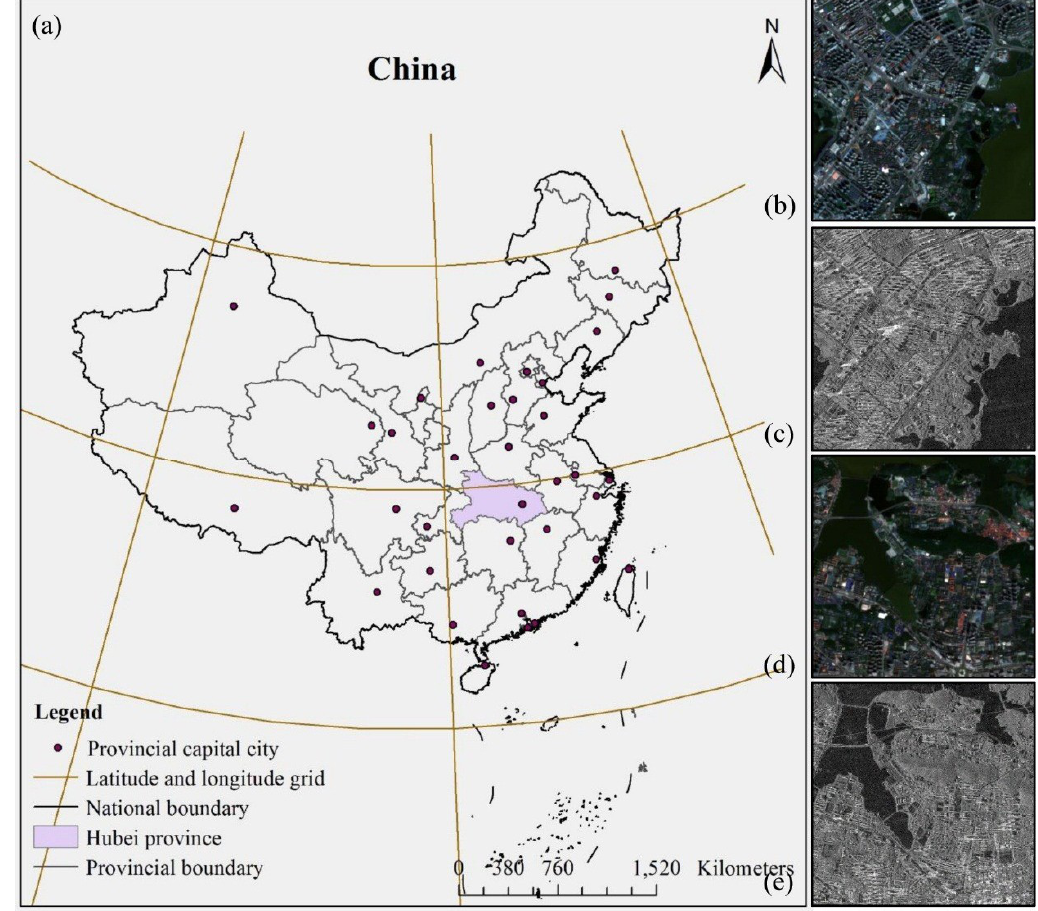
Figure 1. The geographical location of the study area: ( a ) map of China; ( b , c ) Sentinel-2A image and TerraSAR image of Site 1, respectively; and ( d , e ) the Sentinel-2A image and TerraSAR image of Site 2, respectively.